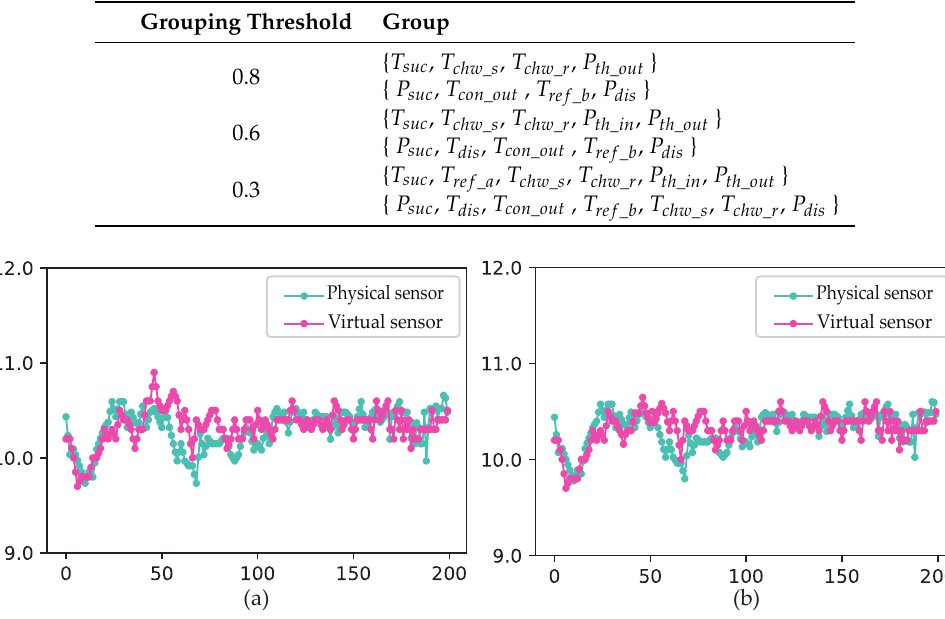
. ( b ) Predictive result of virtual sensor V 2 T suc